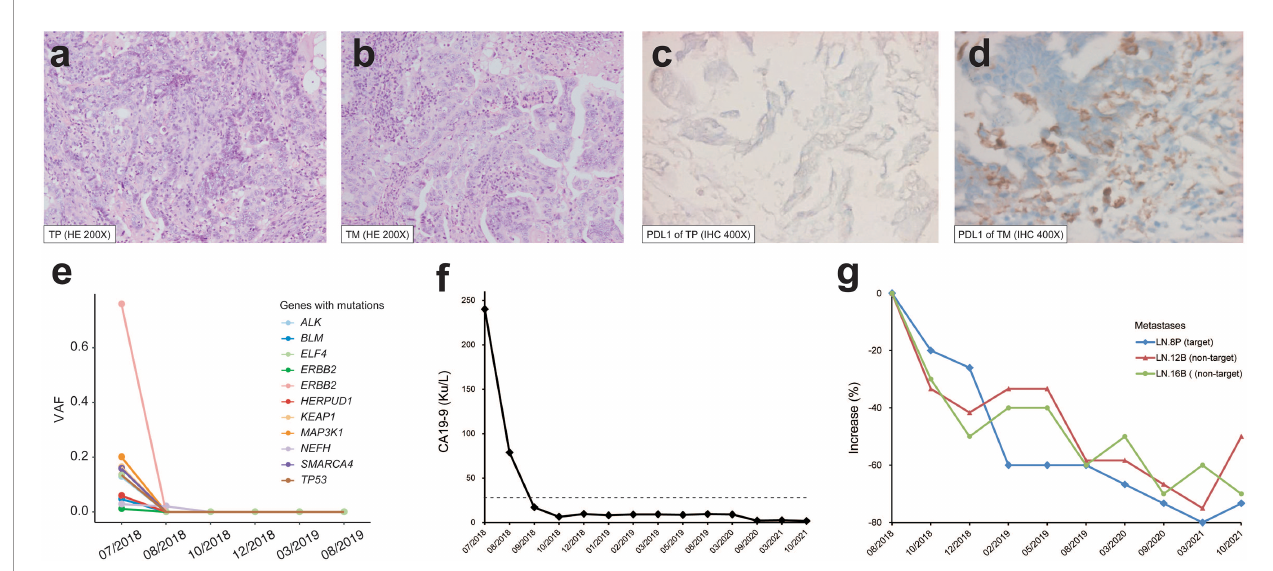
FIGURE 2 | Pathological features and therapeutic response of the patient. H&E staining (×200) of (A) primary tumor (TP) and (B) lymph node metastasis (TM). PD- L1 staining (×400) of (C) TP and (D) TM. (E) Variant allele frequency (VAF) change of cfDNA mutations during the treatment. (F) CA19-9 level during the treatment. The dashed line indicates the normal upper limit. (G) Size change of target and non-target lesions of metastatic lymph node. LN-8P with a short diameter of 1.5 cm after surgery on baseline was used for ef fi cacy